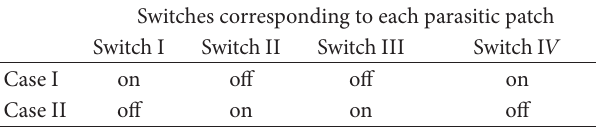
Table 1: Switch configuration for antenna beam